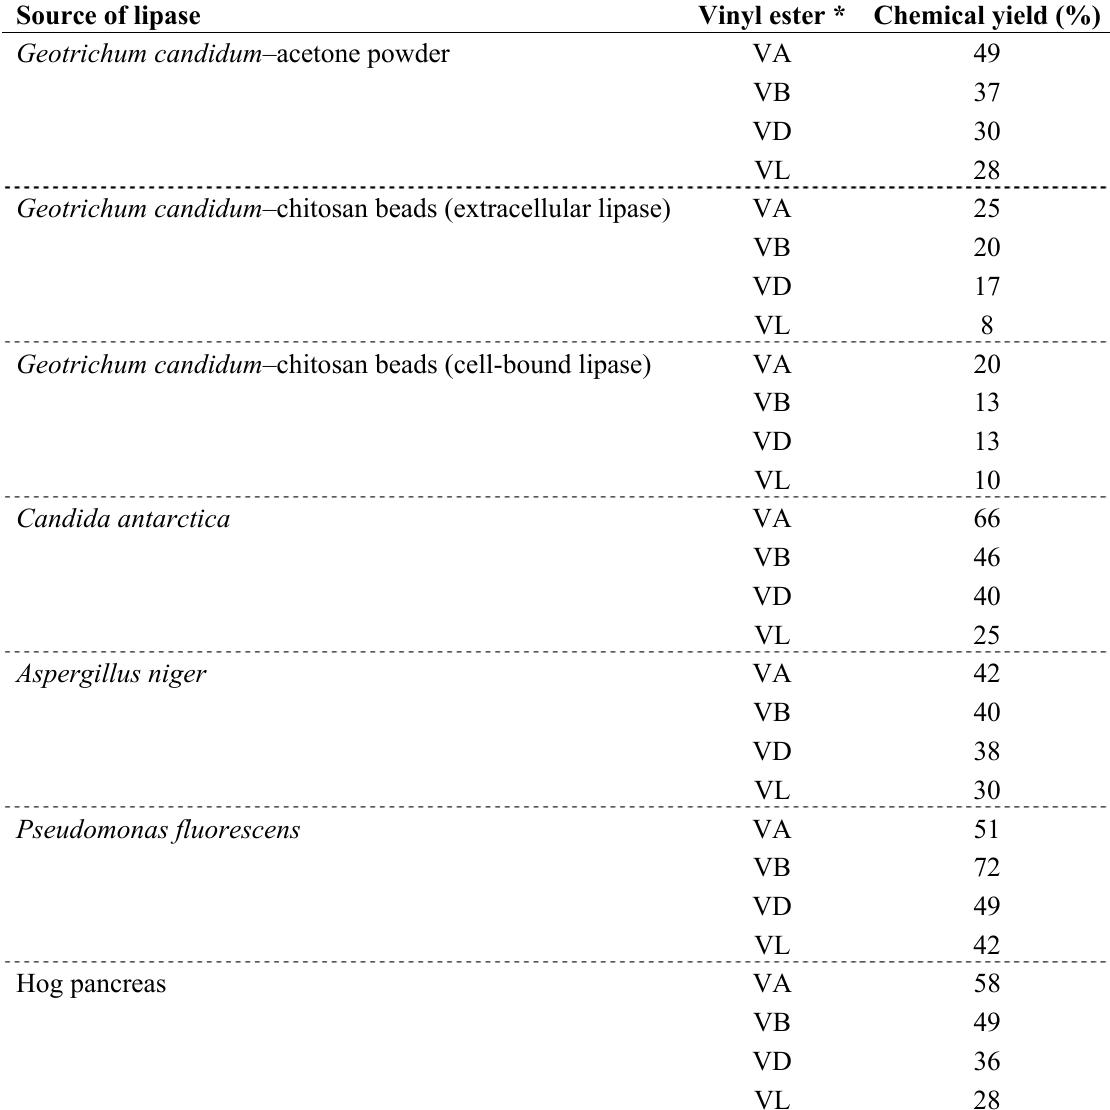
Table 2. Chemical yields of transesterification catalysed by lipases (the reaction was repeated twice using two independent synthetic procedures. The average values of the rates are reported in the